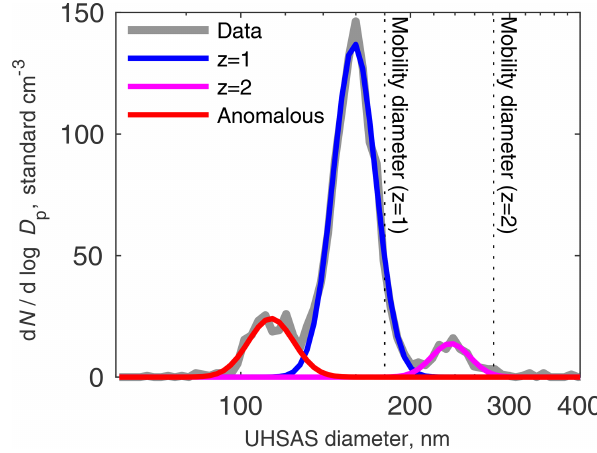
Figure 6. UHSAS size distribution from a DMA selecting 180nm particles at 1.44 ◦ S, 5 ◦ E at 1919m altitude on 23 October 2018 around 14:00UTC. Colored curves are lognormal fits to the gray data line.